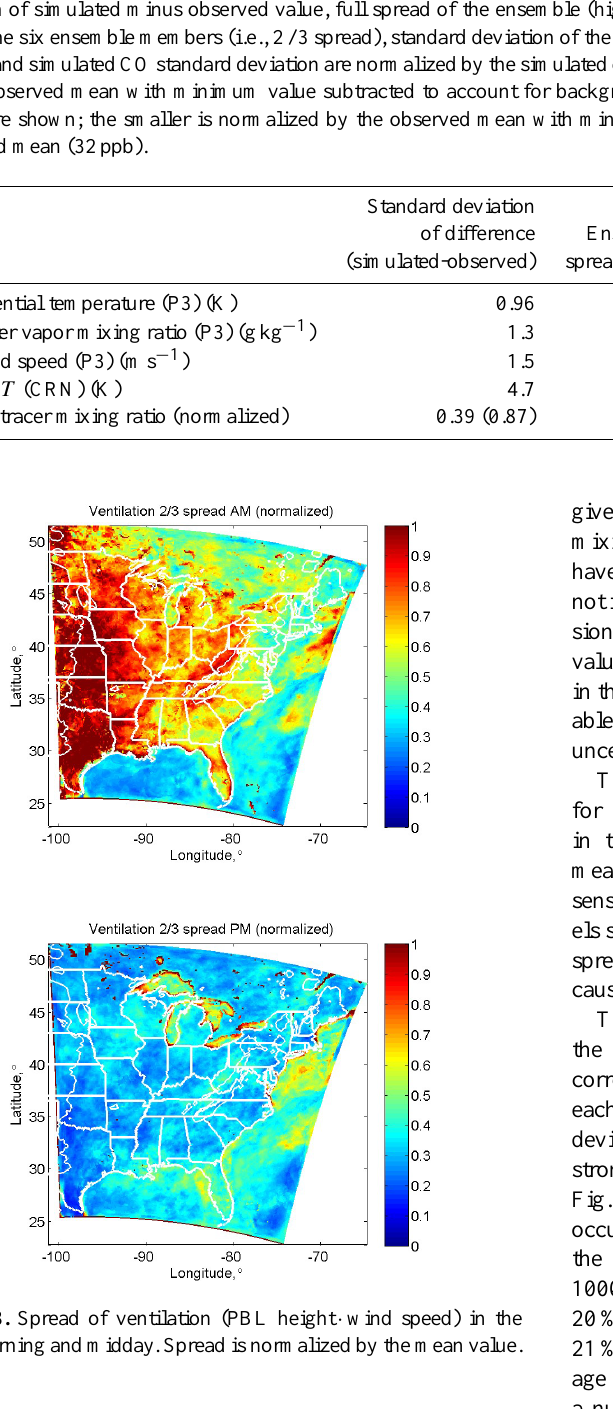
is smaller but the spatial distribution of values is